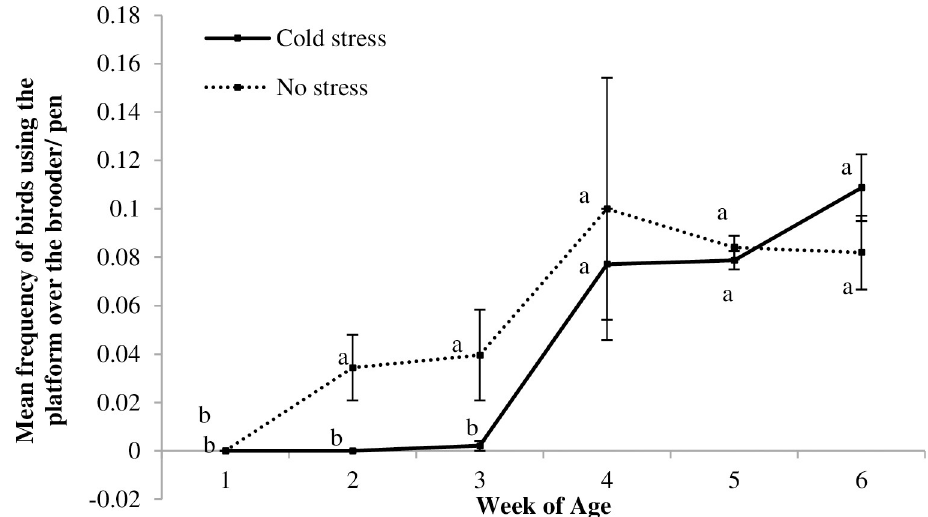
Fig 11. Use of the platform over the hide area for CSTR and NSTR birds. Mean (+ SE) frequency of birds using the platform over the hide area for the Cold Stress (CSTR) and No Stress (NSTR) treatments across different weeks; (a-b) letters indicate differences within each treatment across weeks; no differences among treatments were observed in post hoc comparisons regarding each observed week.